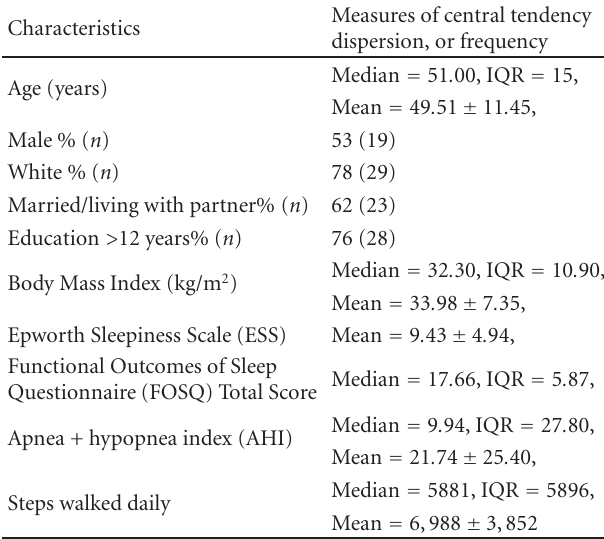
Table 1: Demographic and clinical characteristics of sample ( N =